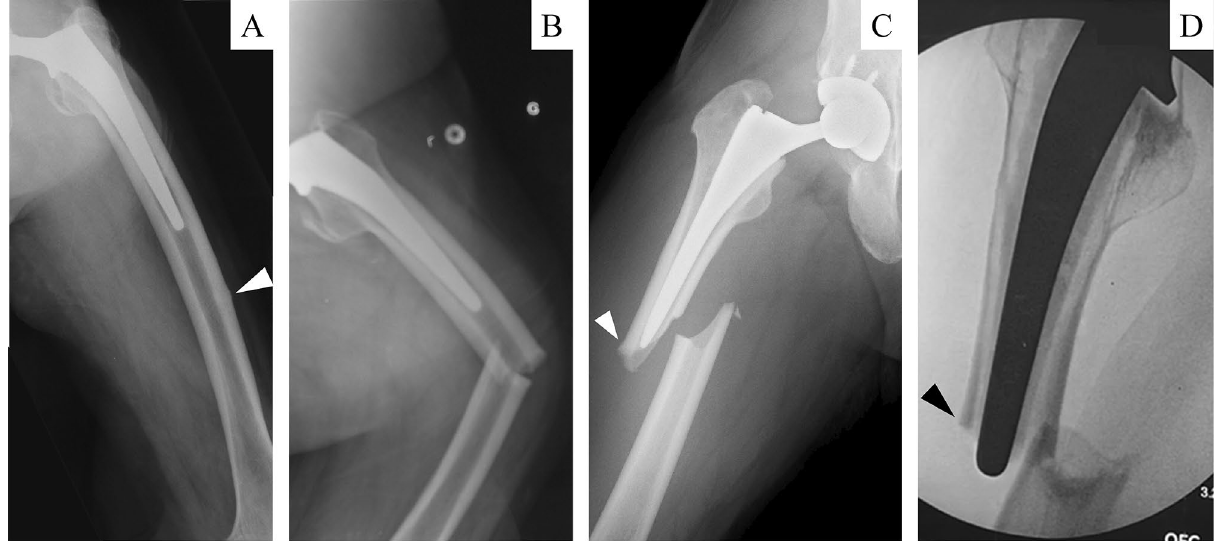
Figure 1. Atypical periprosthetic femoral fractures (APFF) ( A ) Incomplete fracture with uncemented stem inserted (arrowhead: localized periosteal reaction of the lateral cortex). ( B ) Progression from lateral cortex reaction to full periprosthetic femoral fracture. ( C ) APFF with uncemented stem inserted (arrowhead: localized periosteal reaction of the lateral cortex). ( D ) APFF with cemented stem inserted (arrowhead: localized periosteal reaction of the lateral